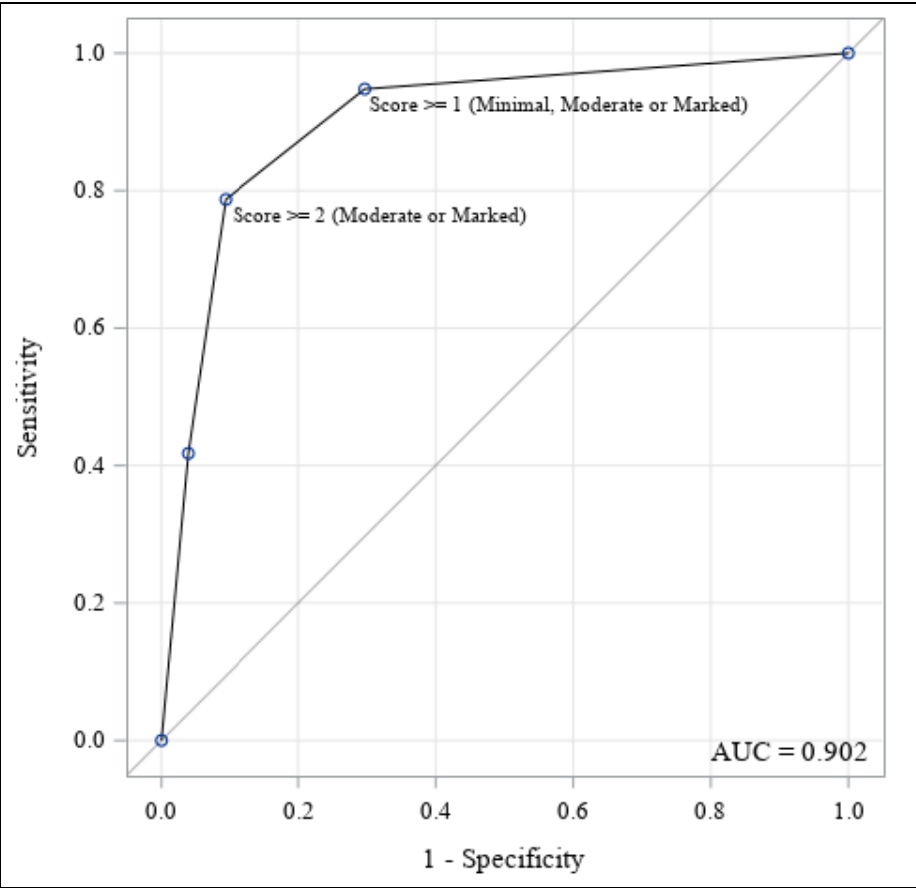
Figure 3. ROC curve (with the AUC) of the model with the CESM enhancement intensity as a predictor of malignancy.